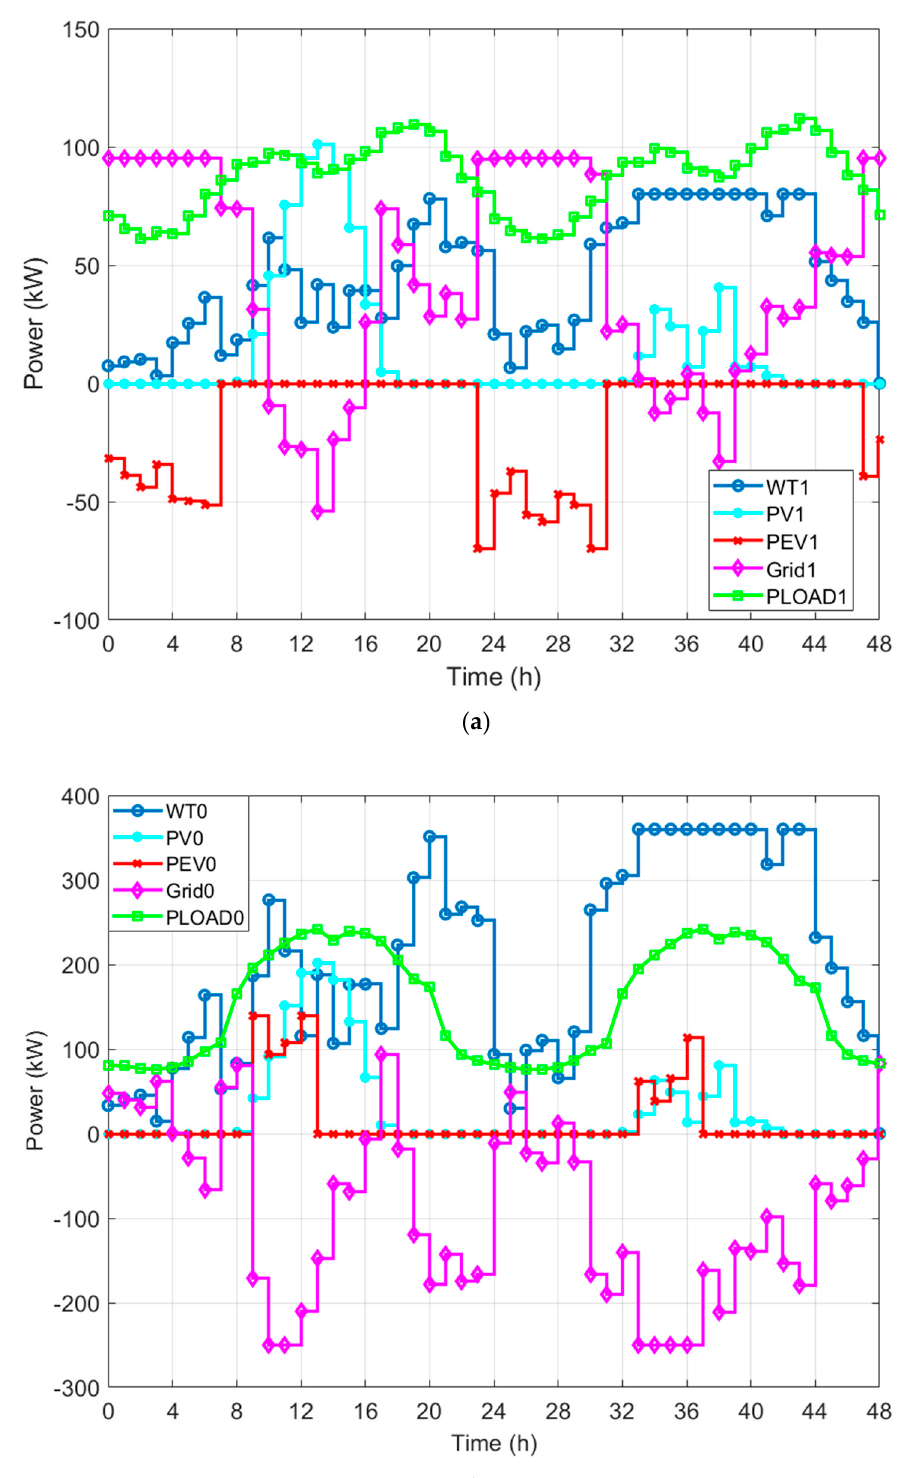
Figure 8. Dispatching results in Case 3: ( a ) Dispatching profiles of RMG1; ( b ) Dispatching profiles of OBMG.